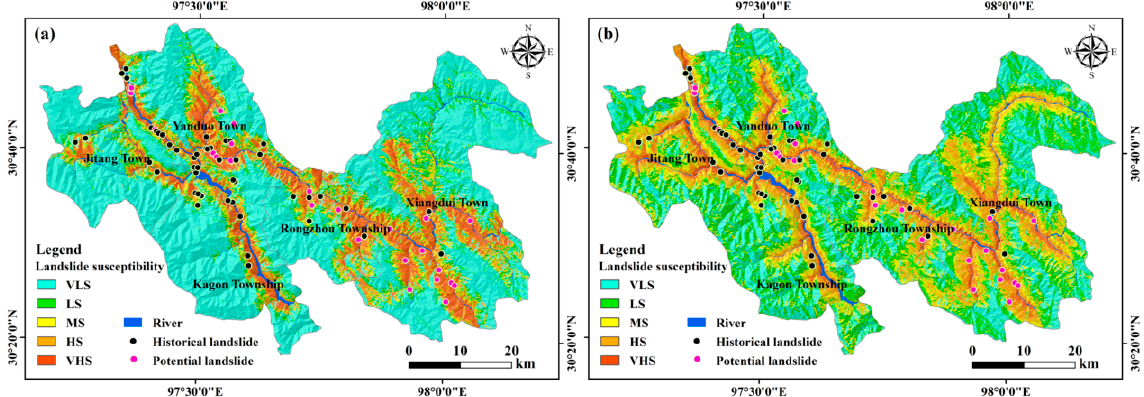
Figure 9. Landslide susceptibility evaluation maps generated by the ( a ) SVM and ( b ) CNN algorithms. See Figure 8 for the meaning of the legend.